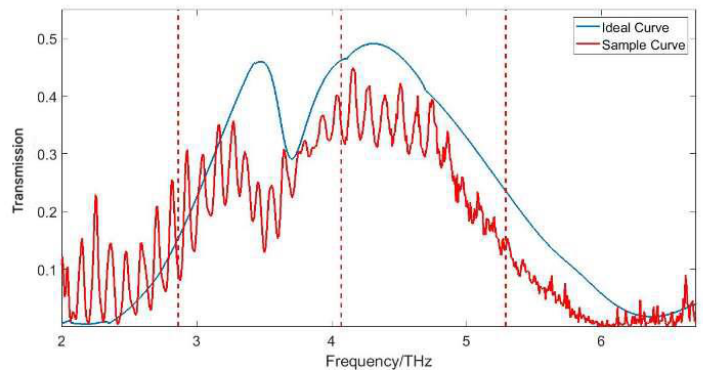
Figure 7. Comparison of sample simulation filter curve and actual measurement filter curve.